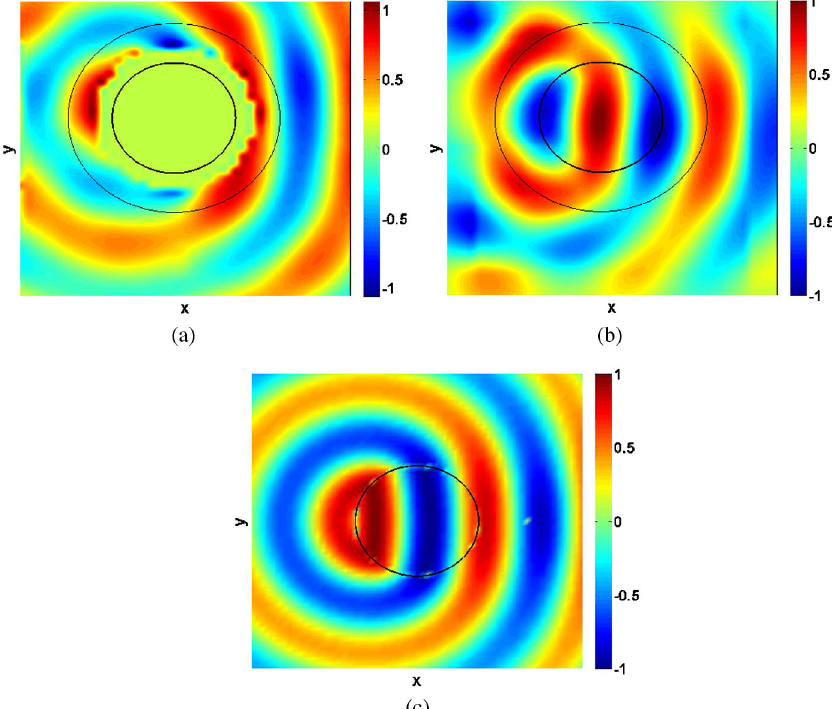
FIG. 7. (a) The measured real part of the electric field created by the magnetic-dipole array alone in the presence of the aluminum cylinder. The larger circle is the circle on which the near-field data are used to calculate the far-field patterns. (b) The measured scattered field of the aluminum cylinder found by subtracting the total field shown in Fig. 4(a) from the measured incident field (not shown). The larger circle is the circle on which the near-field data are used to calculate the far-field patterns. (c) The simulated real part of the scattered electric field of the cloak computed using COMSOL